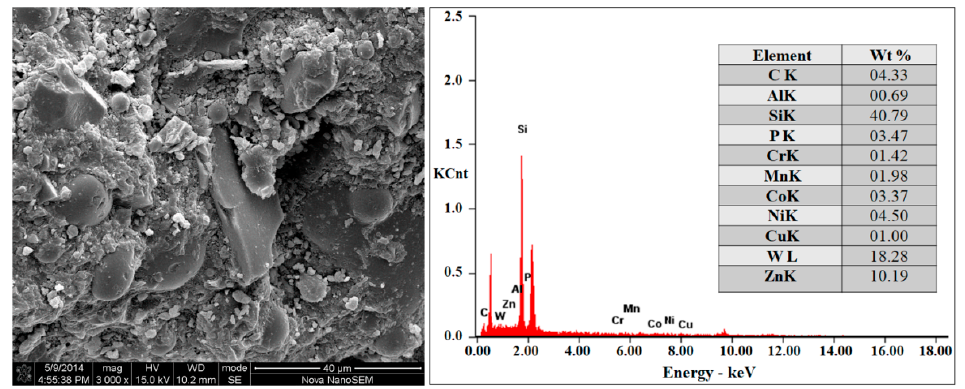
Figure 12. SEM-EDAX analysis of bacterially leached depopulated shredded PCBs at 8% PD, pH 2.0, and 308 K.